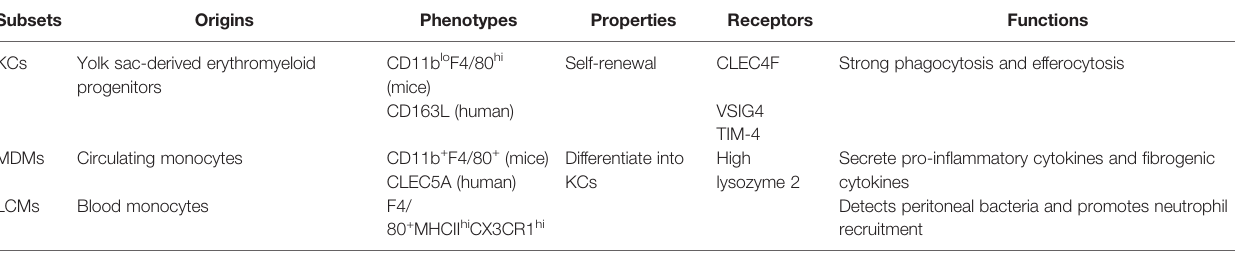
TABLE 1 | Characteristics of the liver macrophage